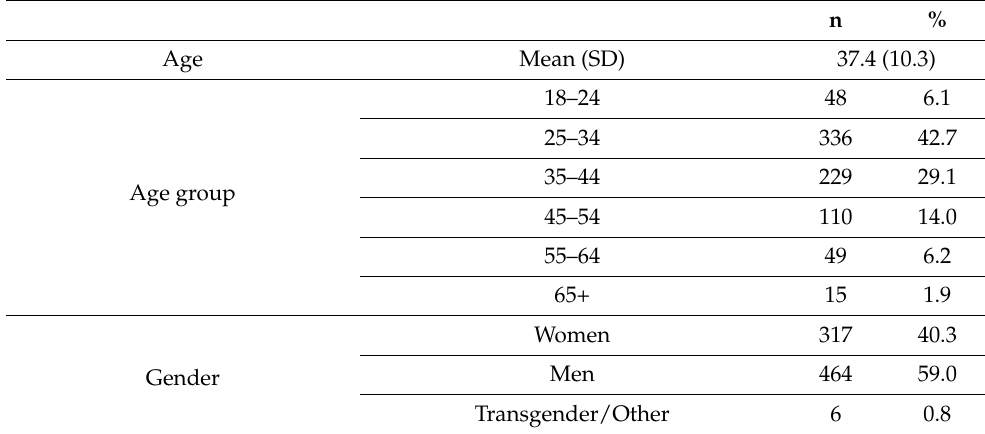
Table 1. Sample Demographic